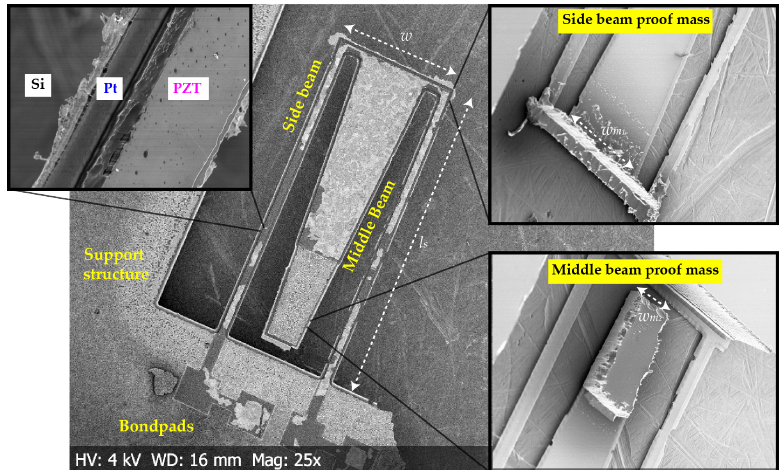
Figure 9. Scanning electron microscope (SEM) image of M-shape at 25 × magnification. Insets contain the backside processed images of the primary and secondary proof masses, and the PZT layer on the bottom electrodes on the side-beam